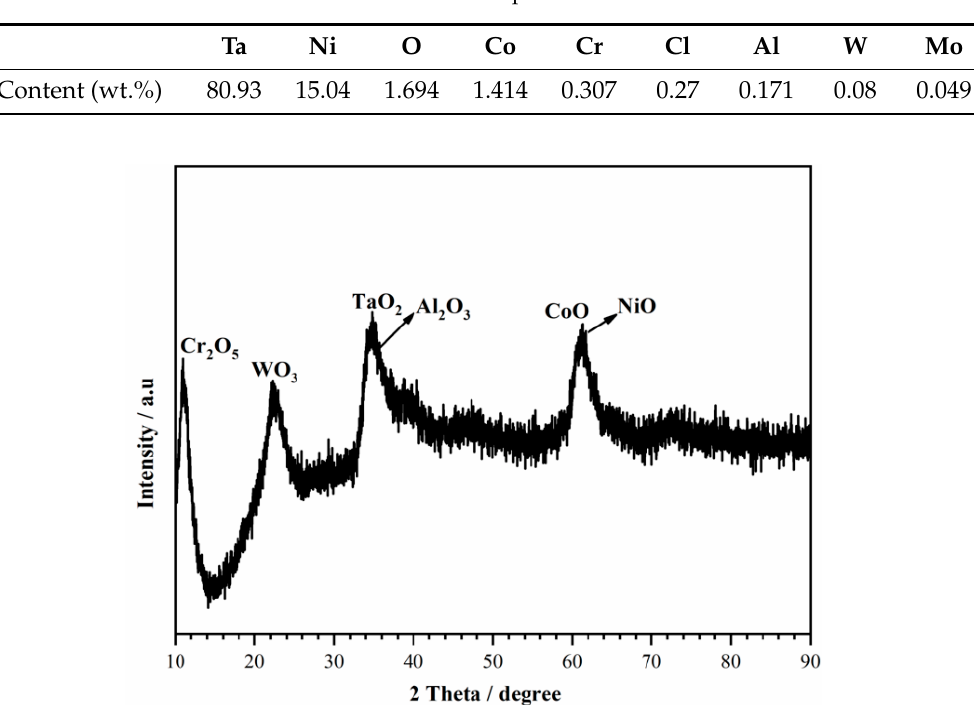
Figure 7. XRD spectra of corrosion products.